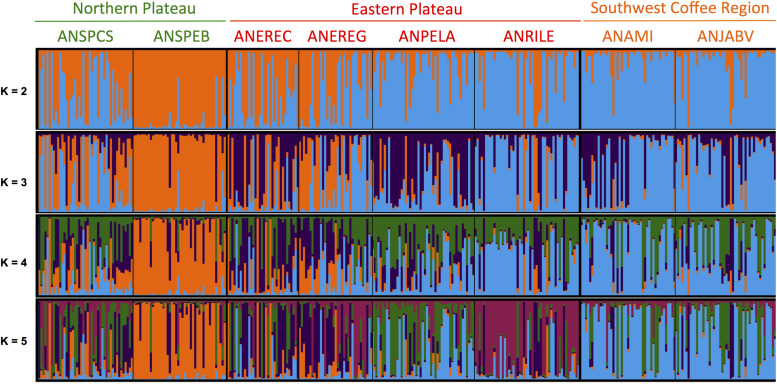
Population structure of seedling rootstocks across eight orchards of “Hass” avocado as inferred with an unsupervised Bayesian clustering approach implemented in STRUCTURE (Pritchard et al., 2000) using 13 SSR markers. A graphical representation of the Q-matrix is shown, where each stacked bar corresponds to a seedling rootstock, and within bar colors represent subpopulation assignment probabilities given K possible clusters. Orchards are sorted according to the agroecological region, and their names are shown and colored accordingly at the top of the bar plot (following Figure 1). K-values of possible subpopulations ranged from 2 to 5. Optimum K-value of 3 was determined based on cross-run cluster stability of five independent runs and likelihood of the graph model (Supplementary Figure 9) from Evanno et al. (2005). Higher K-values did not contribute further divergence yet increased overall admixture levels. Q matrix of population admixture at K = 3, and the admixture levels are summarized in Supplementary Table 6. SSR markers (2) were designed by Sharon et al. (1997) and Ashworth et al. (2004) and were prioritized according to their polymorphism information content following Alcaraz and Hormaza (2007).